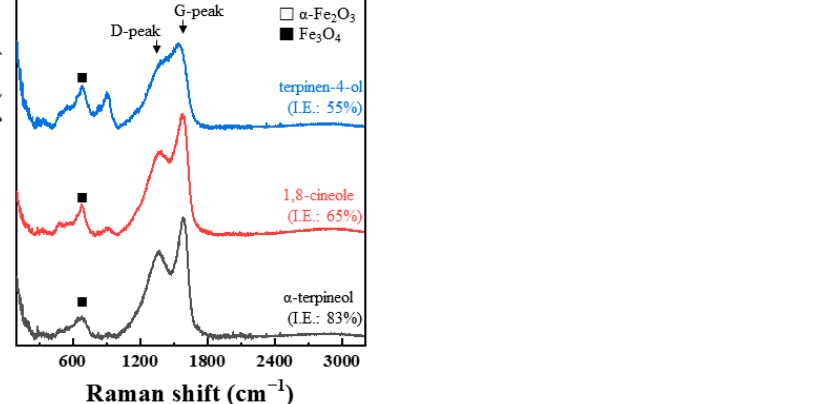
Figure 11. Raman spectra analyzed from the surface of STS specimens after immersion for 168 h in 1 M HCl solution at 298 K with α -terpineol, 1,8-cineole, and terpinen-4-ol of 0.75 g/L.